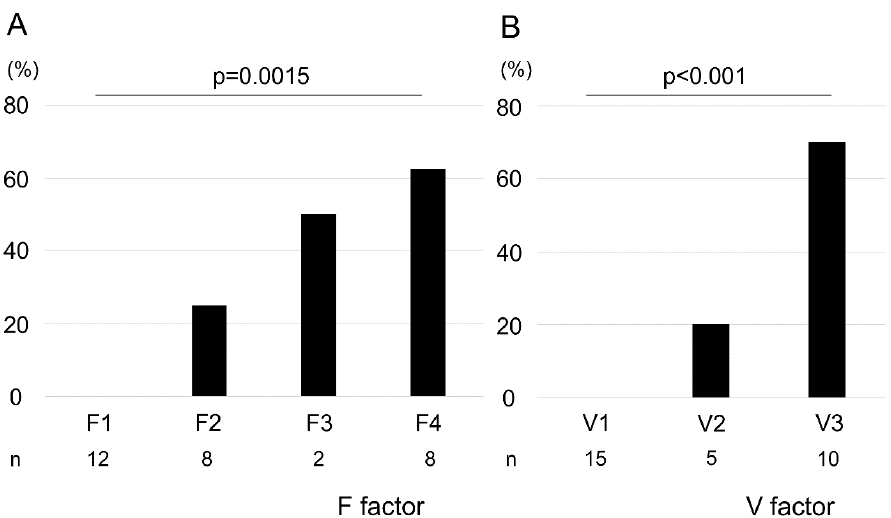
Figure 1. Association between pathological malignancy rate and F–V factors. Pathological malignancy rates increased with increasing F- and V-factor scores ( A , F factor; B , V-factor). Statistical significance was determined using the Cochran–Armitage trend test.